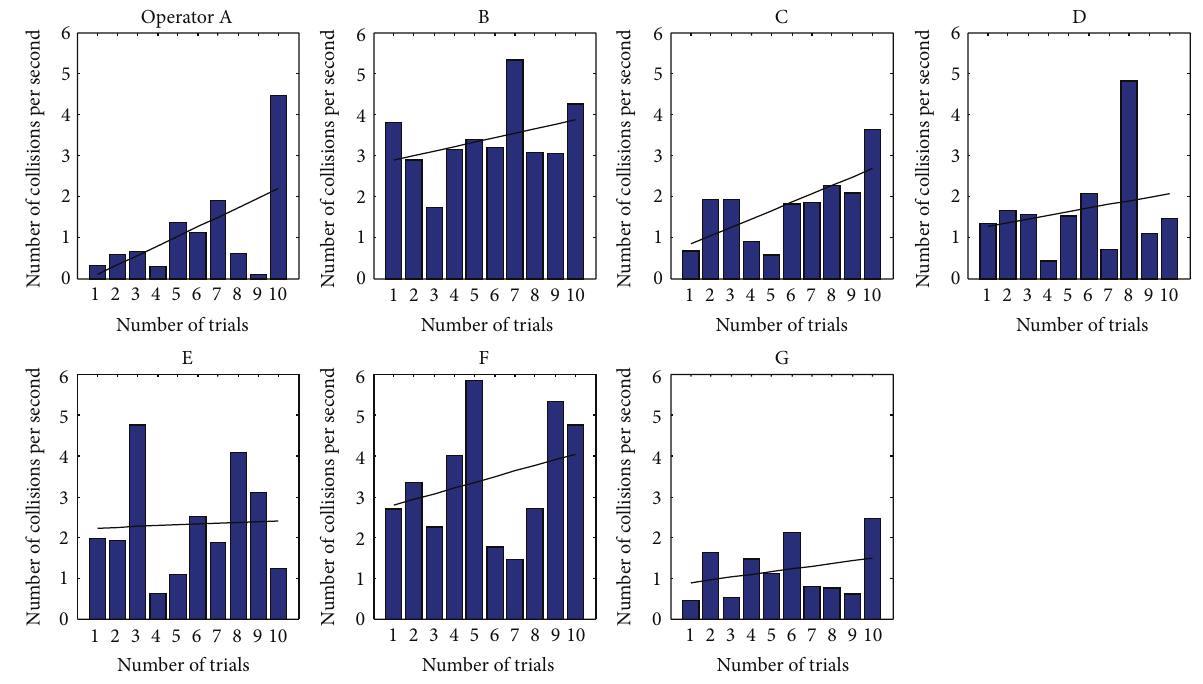
Figure 6: Transition of the number of collision for all operators ( C -index).